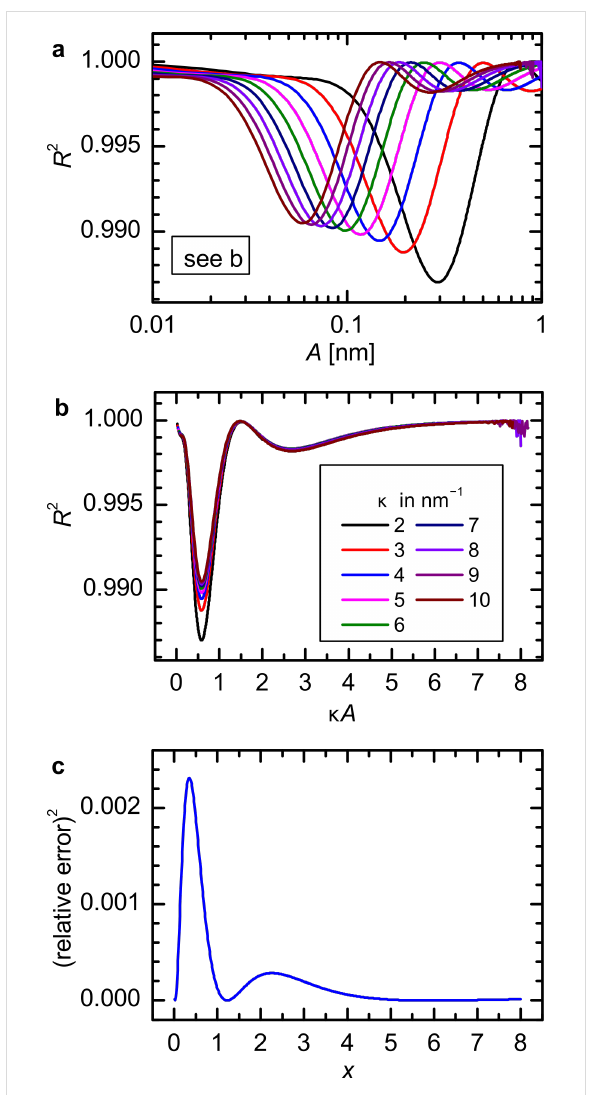
Figure 9: (a) Amplitude dependence of the CoD for Morse force law with different decay constants κ (see legend in (b)). (b) The same data shown in (a) but with a scaled abscissa κ A . The minima and maxima coincide on the scaled axis. (c) square of the relative error SqRE of the approximation of the function T ( x